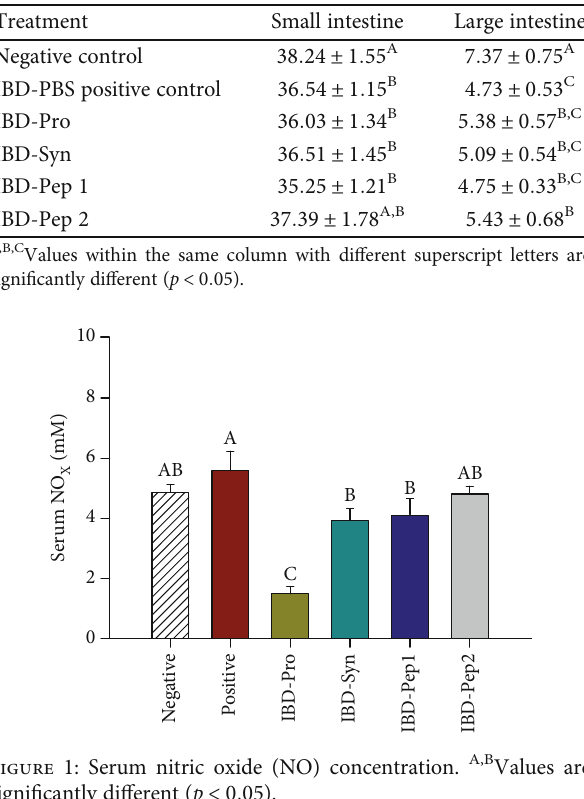
Table 7: Di ff erences in small and large intestine lengths among the groups (unit: cm).